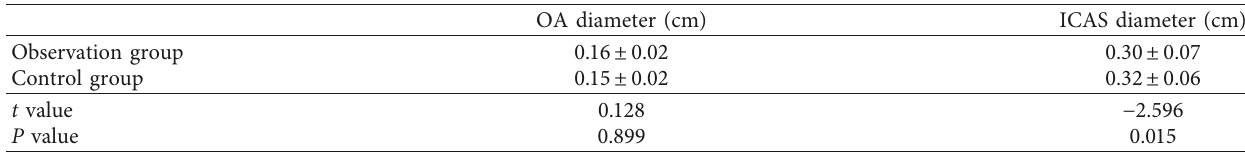
Figure 3: CDFI examinations of the SPCAs and the measurement process. The major parameters are PSV, EDV, and RI. Table 1: The diameter of the ICA siphon and the OA.